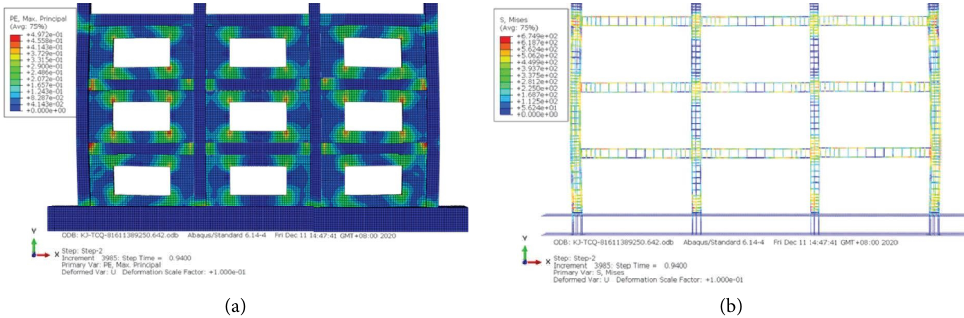
Figure 19: Specimen KJ-T-8. (a) Concrete plastic strain contour. (b) Steel bar stress